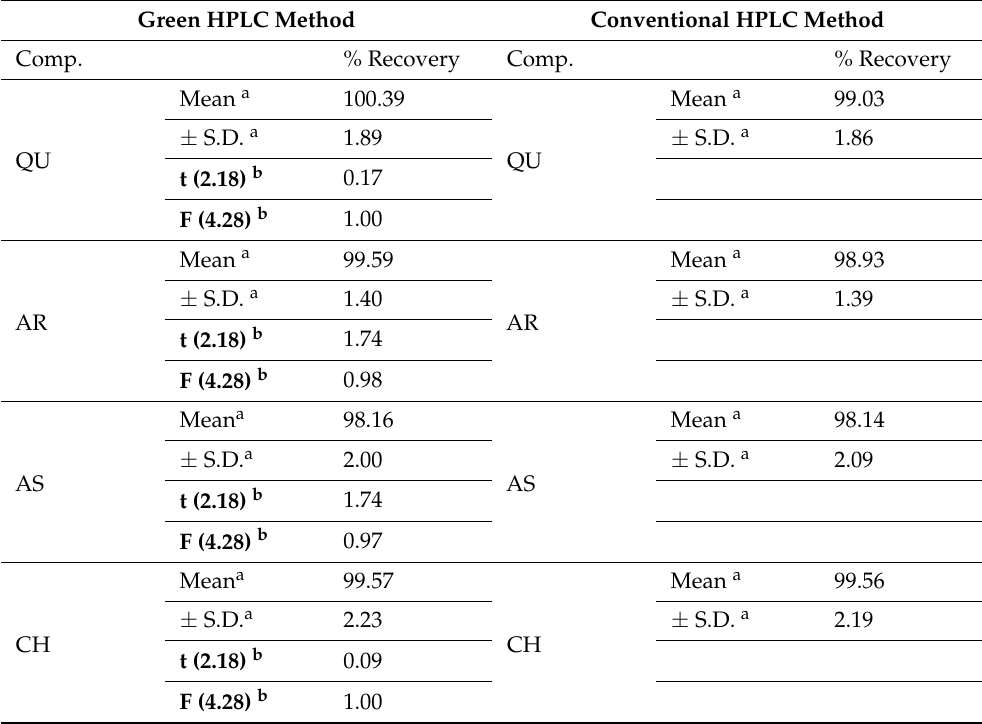
Table 3. Determination of QU, AR, AS, and CH in tablet dosage forms by the proposed green HPLC method in comparison with the conventional method. Green HPLC Method Conventional HPLC Method Comp. % Recovery